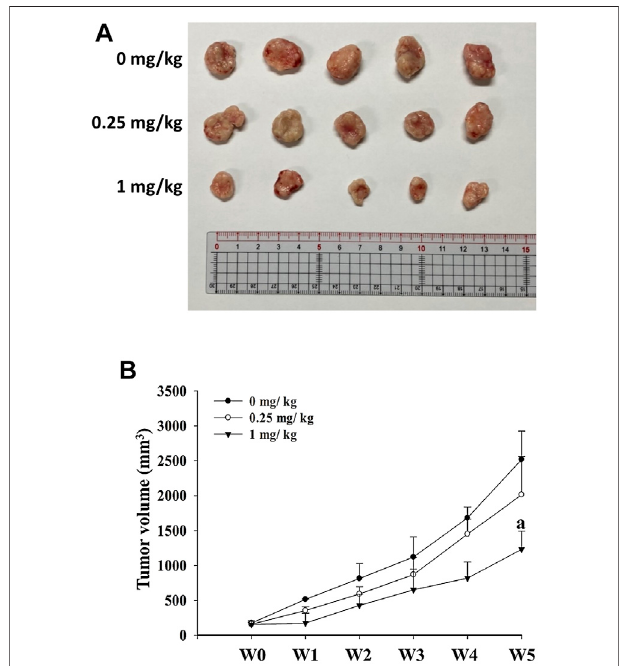
FIGURE4| Risperidoneinhibits thegrowth ofxenograftKATO-IIItumor. Athymic nude mice were divided into three groups ( n = 5 per group) receiving 0, 0.25, and 1 mg/kg risperidone, respectively. (A) Representative images of excised xenograft tumors from different groups of mice. (B) Line graph shows the xenograft tumor volumes of mice from different grouips in different weeks. The letter a indicates a signi fi cant difference ( p < 0.05) compared with control (0 mg/kg).